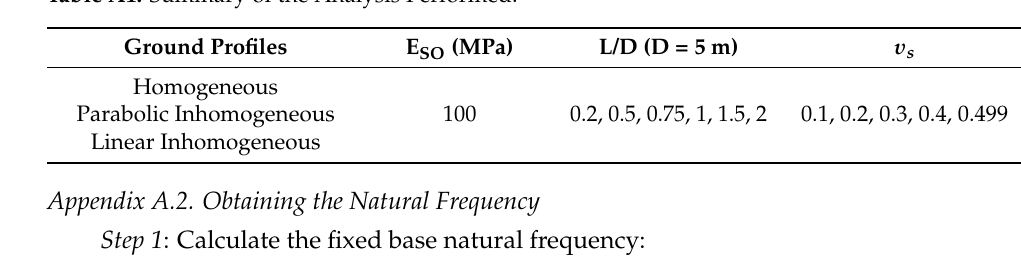
Table A1. Summary of the Analysis